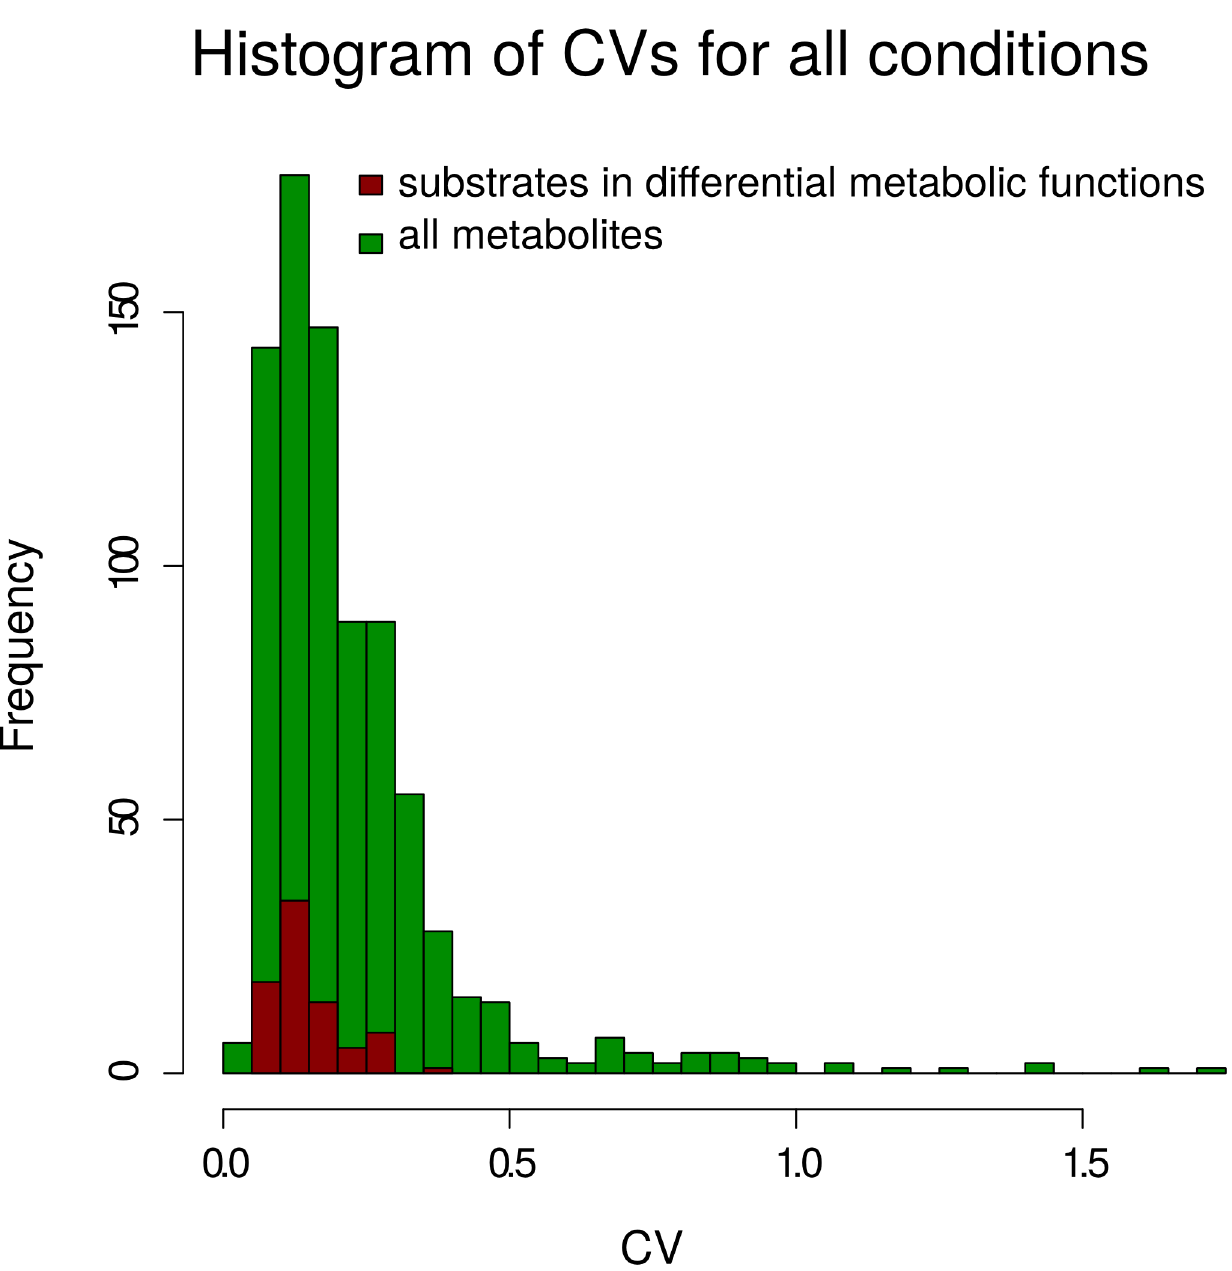
Figure 3. Histogram of temporal coefficient of variation for metabolites. Distribution of CVs over all measured metabolites (green) and all metabolites identified as substrates in a differentially behaving functions for the respective conditions (red). The plot summarizes the distributions over all eight considered conditions.